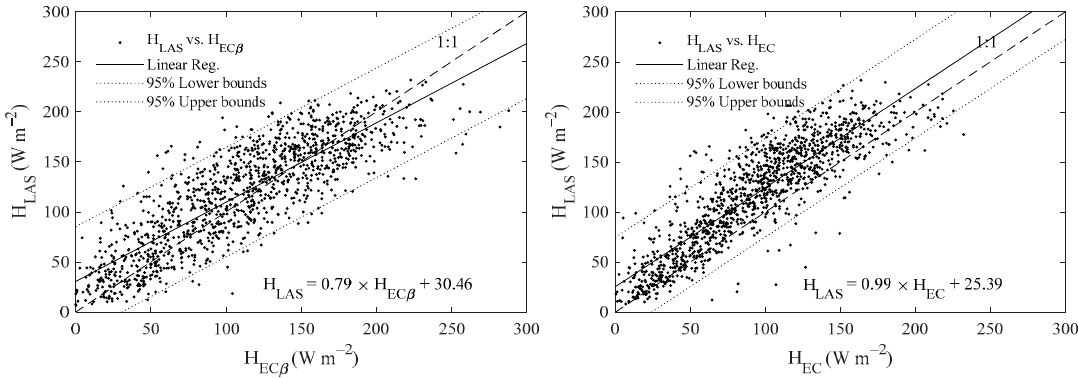
Figure 4. Comparisons between H LAS and H EC β ( right ), H LAS and H EC Re ( left ), along with corresponding linear regression and 95% confidence intervals.